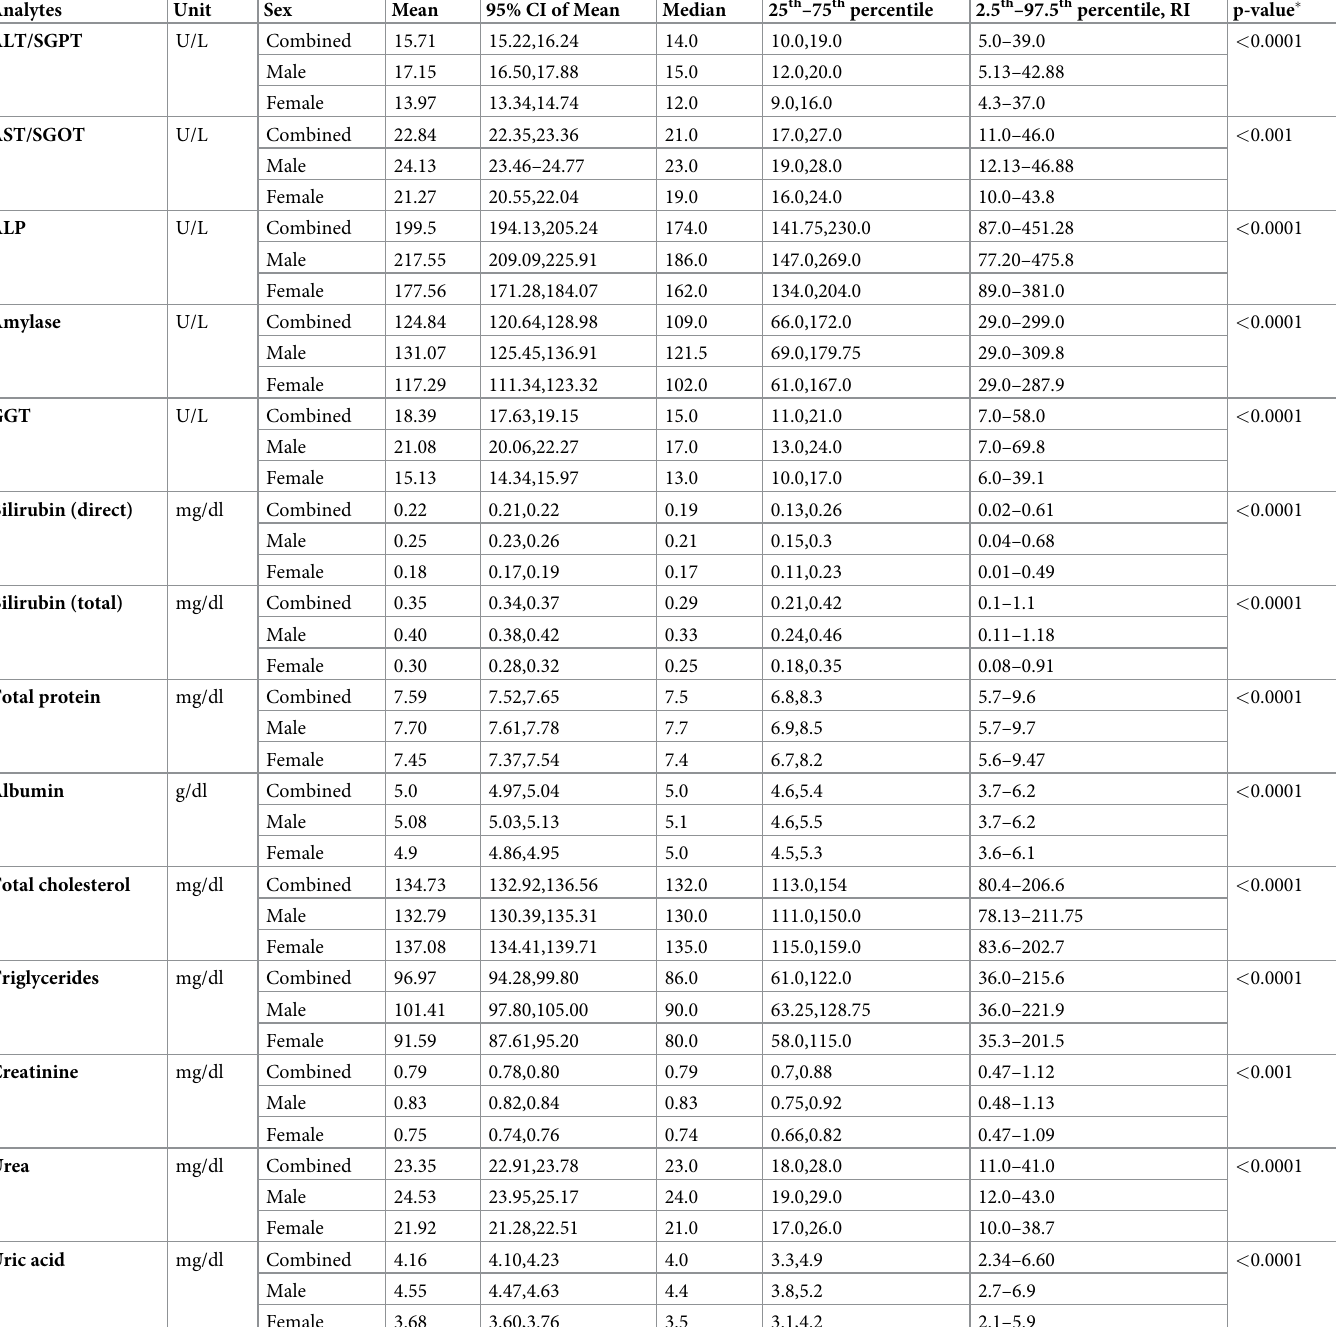
Table 2. The RIs of clinical chemistry parameters among blood donors in Amhara National Regional State, Ethiopia, 2017 (N = 1,175; Male = 644, and Female = 531).